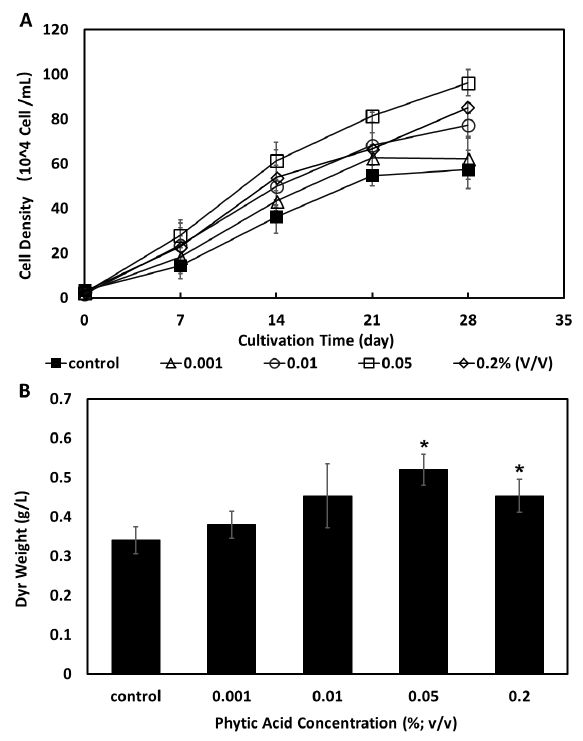
Figure 1: Effect of phytic acid on growth the profile of E. gracilis . (A) Growth curve, (B) Dry weight of Biomass. Asterisks indicate the significant difference ( p < 0.05) between the experimental and control